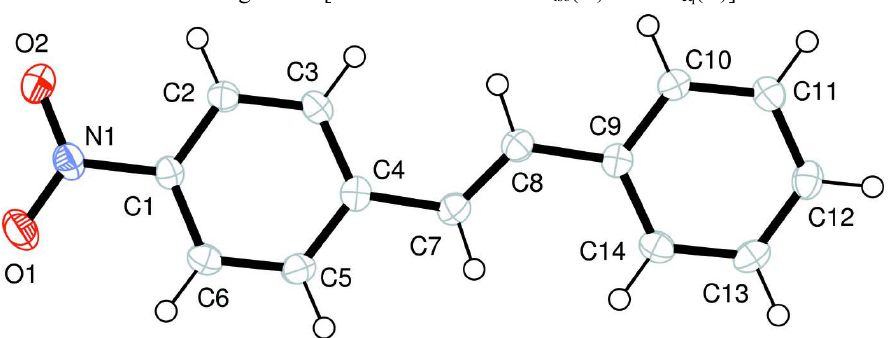
An ORTEP - 3 (Farrugia, 1997) plot of the (I) compound, with the atomic labelling scheme. The shapes of the ellipsoids correspond to 50% probability contours of atomic displacement and, for the sake of clarity, H atoms are shown as spheres of arbitrary